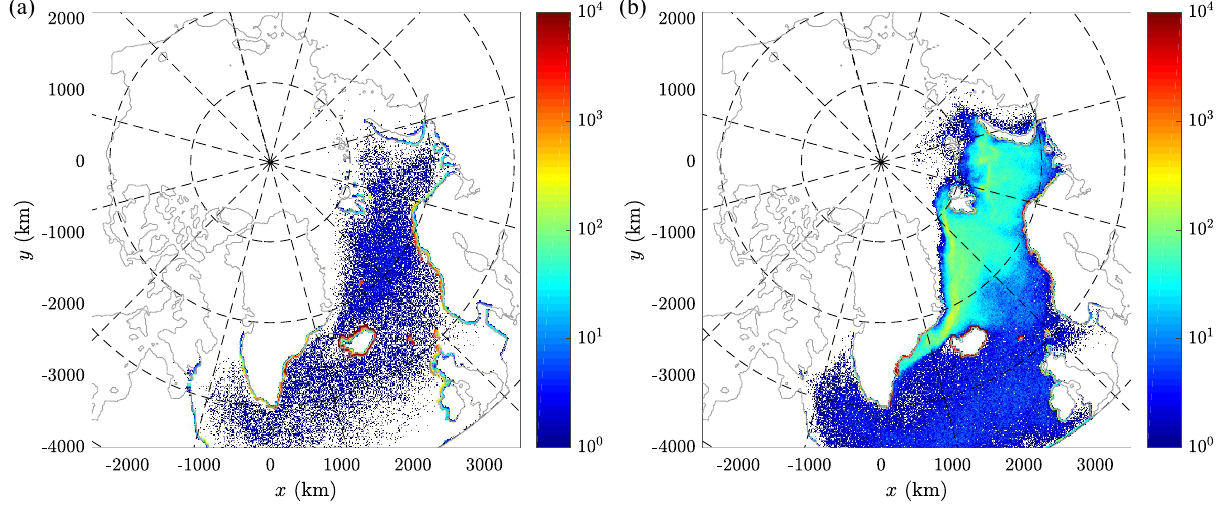
Figure 7. Maps of the spatial density of final positions of particles released from ICE in the period 1993–2017 2 (in number of particles per grid cell, i.e., ∼ 156 km ) in simulations with ( a ) and without ( b ) Stokes drift. The color scale is logarithmic, grid cells with no particles are white. (Maps created with Matlab version 2016b, https:// www. mathw orks.